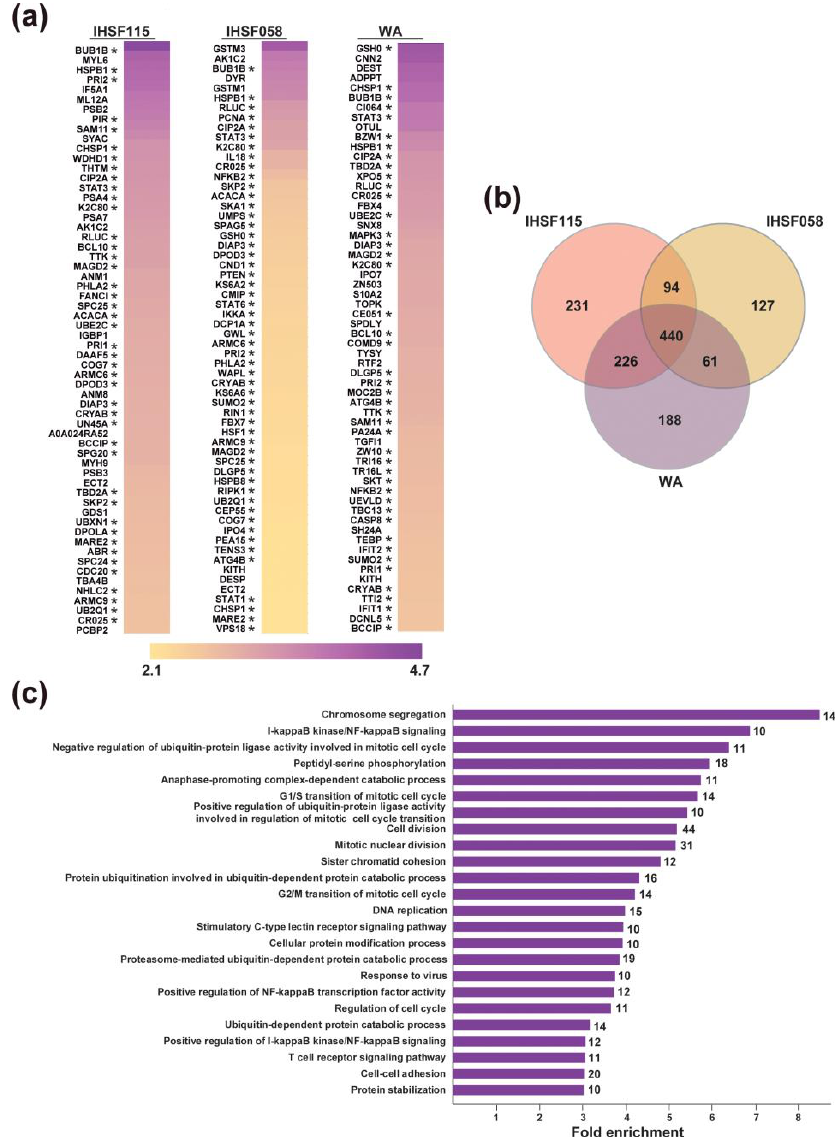
Figure 3. Proteomic analysis of compound-induced protein unfolding. ( a ) Parallel cultures of M1 cells were exposed to 25 µM IHSF115, 25 µM IHSF058, 12.5 µM WA or vehicle for 6 h. Deter-